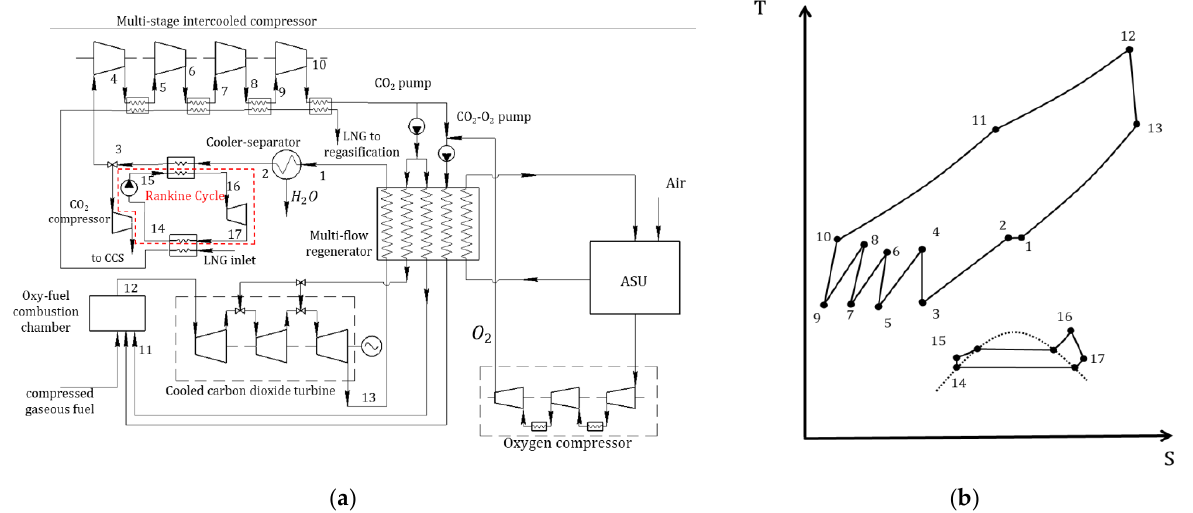
Figure 25. Allam cycle with cooling by means of LNG and WHR: ( a ) schematic diagram; ( b ) T–S diagram [41]. ASU — air separation unit.